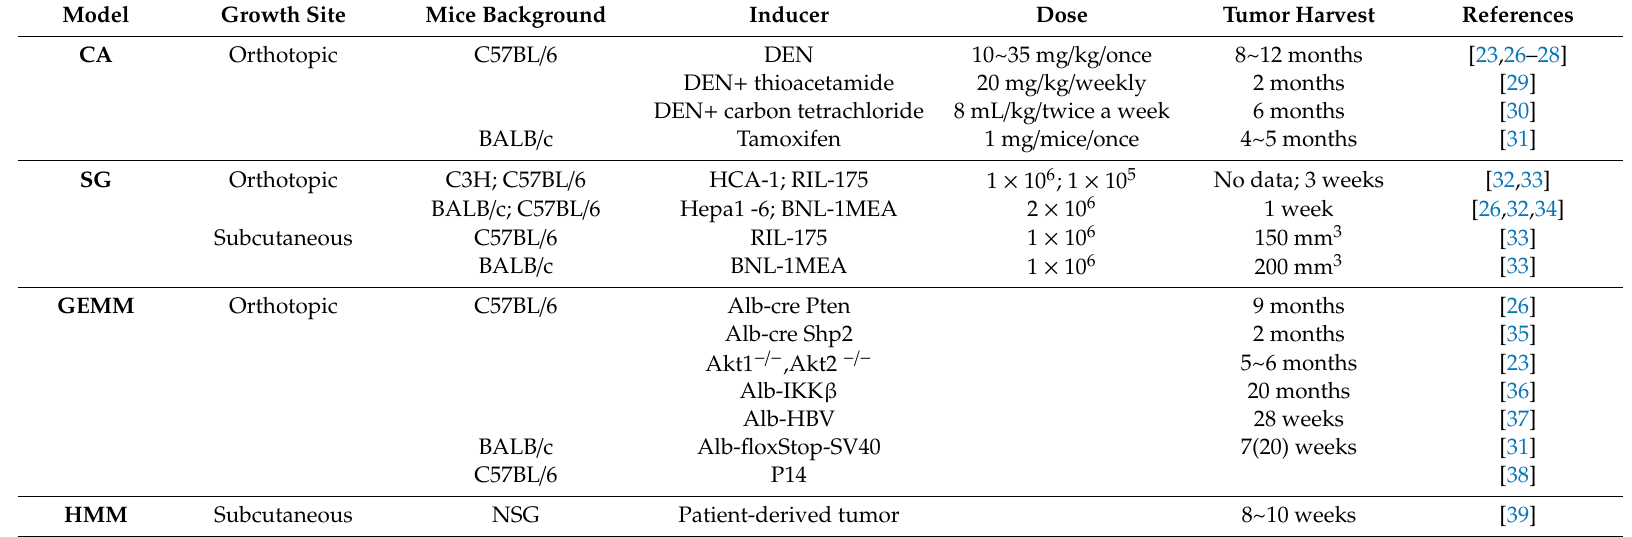
Table 2. Mouse models used for immunotherapy in HCC. (CA, chemotoxic agent mouse model; SG, syngeneic mouse model; GEMM, genetically engineered mouse model; HMM, humanized mouse model; DEN,